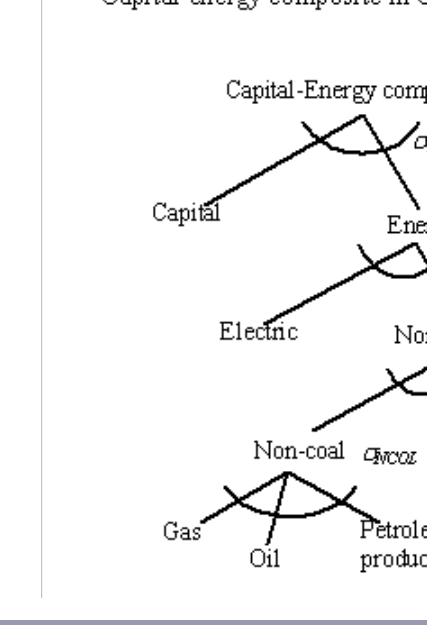
Fig. 3 . Input structure of biofuel production in